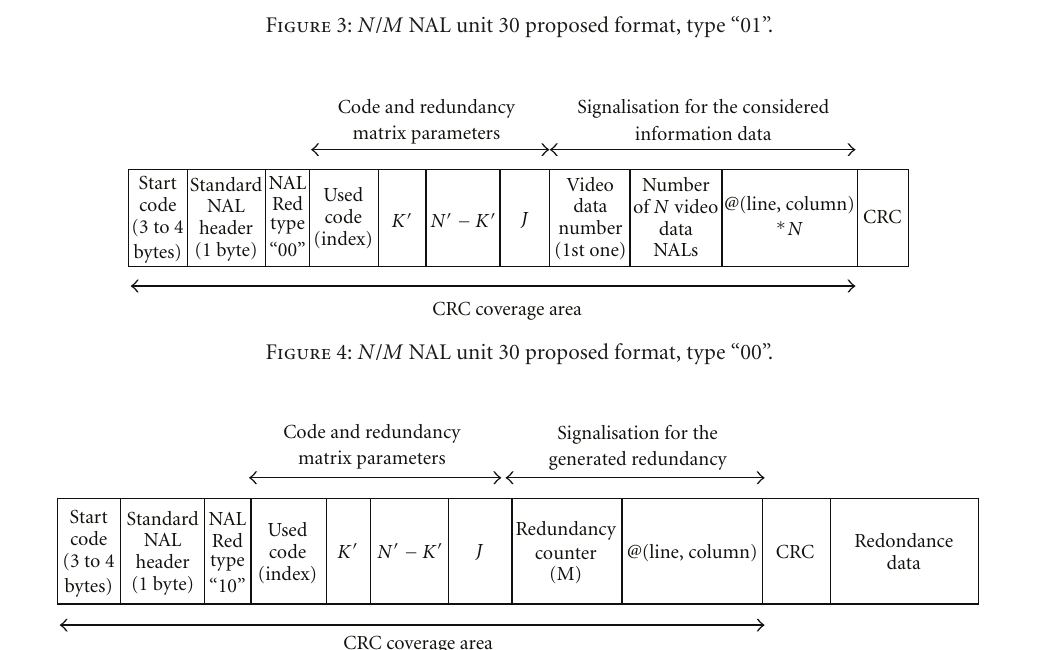
Figure 5: N / M NAL unit 30 proposed format, type